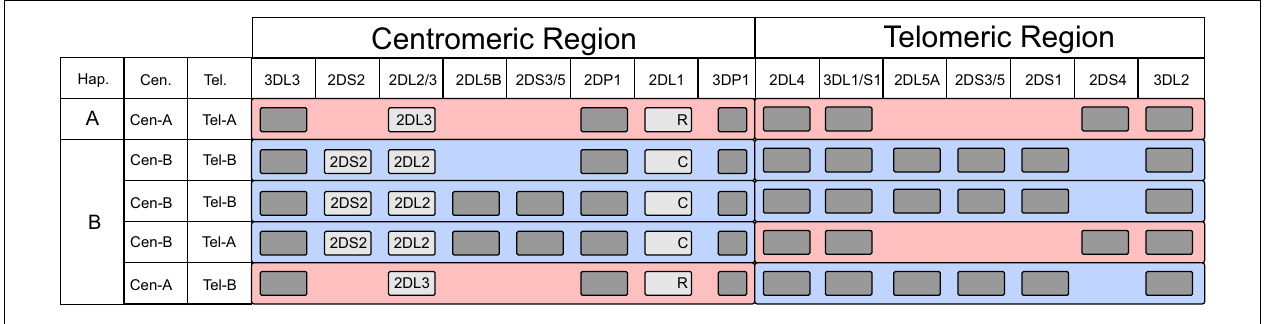
between KIR2DS2 and KIR2DL2. Arginine (R) and cysteine (C) residues encoded at position 245 are identified for the KIR2DL1 allotypes. “Hapl.” denotes overall haplotype designation; “Cen.” and “Tel.” denote designation of centromeric and telomeric segments, respectively. Red shading denotes A haplotype segments, blue shading denotes B haplotype